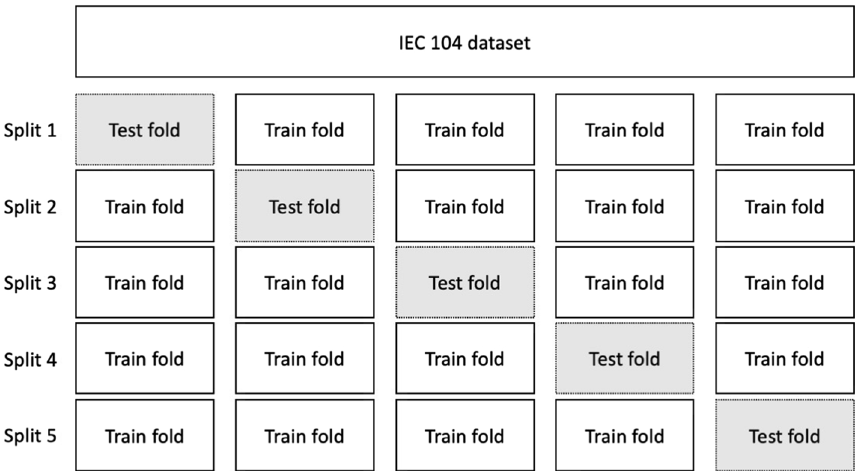
Fig. 4 5-Fold cross-validation on IEC 104